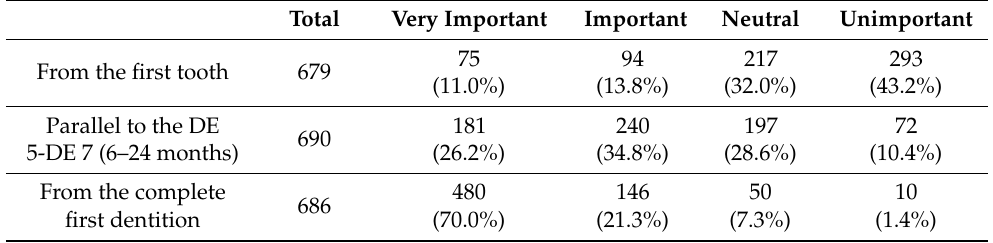
Table 4. Perceived significance of early dental visit by age group in absolute values and in percent